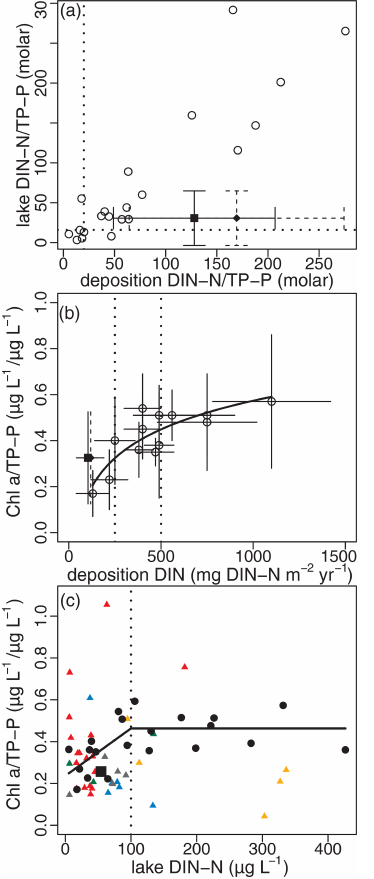
Figure 6. The relationship between atmospheric nutrient deposi- tion, nutrient bioavailability and phytoplankton biomass in Ergaki lakes (black square) in the context of different world data sets. (a) Atmospheric deposition versus lake DIN-N / TP-P molar ratios of several alpine regions elsewhere in the world, as reproduced from Brahney et al. (2015), including Ergaki means and standard devia- tions: precipitation-dependent estimates (rhombus and dashed lines) and literature-corrected estimates (square and solid lines). Verti- cal dashed line represents the referential northern Swedish value (20.1). Horizontal dashed line represents the Redfield ratio (16). (b) Yearly atmospheric DIN-N deposition versus the Chl a / TP- P ratio of 13 Swedish regions, as reproduced from Bergström and Jansson (2006) and Bergström et al. (2005), including Ergaki means and standard deviations (as before). Dashed lines represent approx- imate limits of N, N-P and P limitation areas, according to the au- thors (250 and 500mgDIN-Nm − 2 yr − 1 ). (c) Lake DIN-N concen- tration versus the Chl a / TP-P ratio of different lake districts in the world (black circles) and its segmented regression fit as repro- duced from Camarero and Catalan (2012), including Ergaki me- dians (black square) and particular observations from the follow- ing lakes (triangles): Tsirkovoe (yellow), Oiskoe (red), Raduzhnoe (blue), Karovoe (gray) and Svetloe (green). Dashed line represents the limit between N and P limitation conditions, according to the